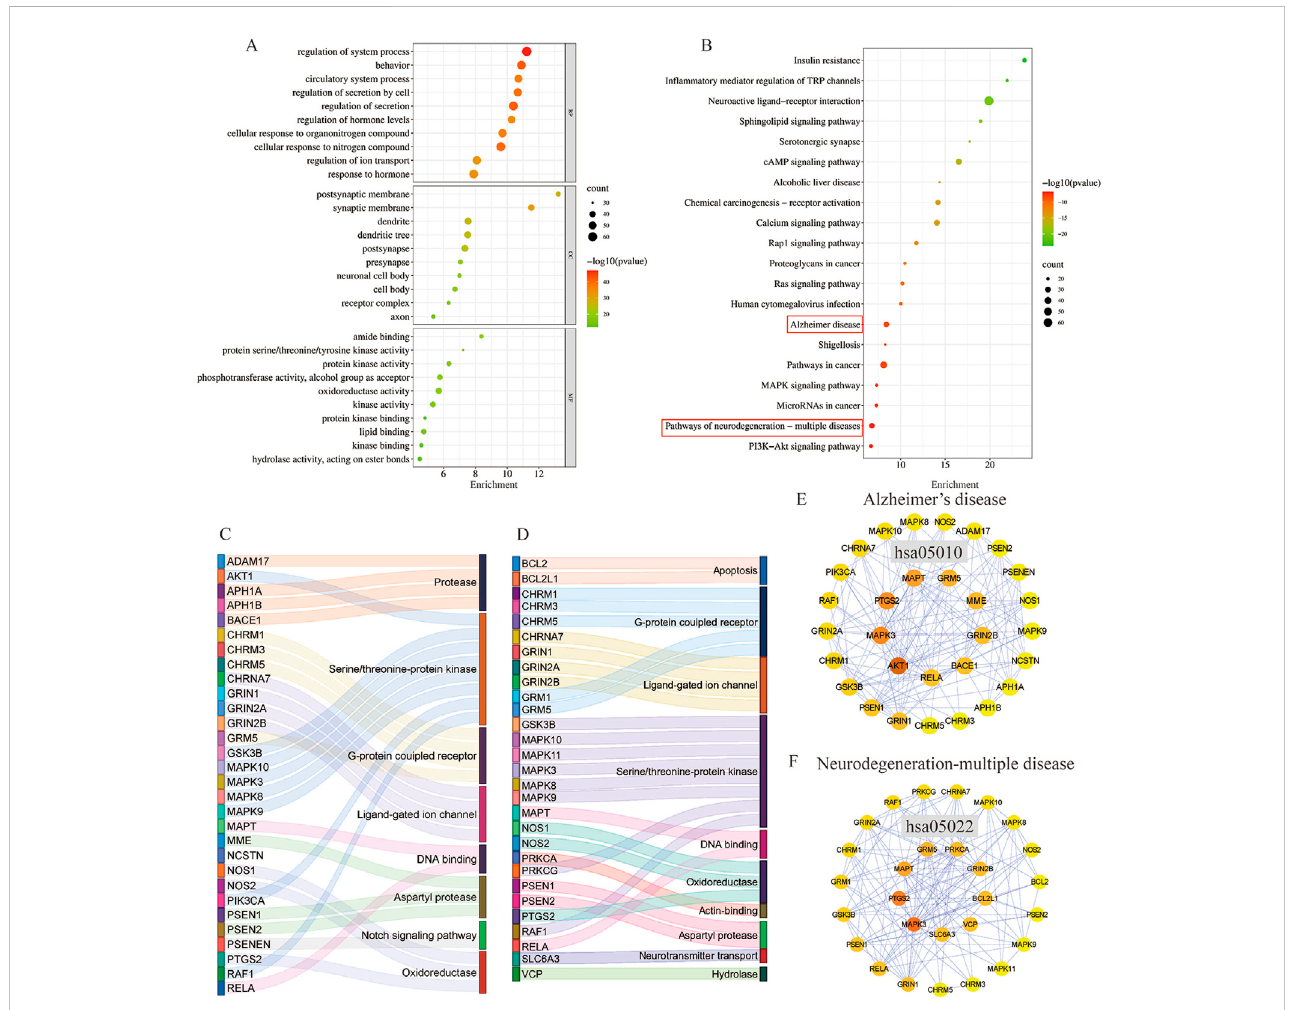
FIGURE 6 GOfunctionenrichmentandKEGGpathwayenrichmentanalysisofADinthetreatmentofMFS. (A) GOfunctionenrichmentanalysisbubblediagram. (B) KEGG pathway enrichment analysis bubble diagram. (C) Sankey diagram of targets involved in the AD signaling pathway. The color of the Sankey diagram indicates the corresponding functional classi fi cation of the gene (classi fi cation according to MF of each target). (D) Sankey diagram of targets involved in the neurodegeneration-multiple disease signaling pathway (classi fi cation according to MF of each target). (E) PPI network of enriched genes in the AD signaling pathway. (F) PPI network of enriched genes in neurodegeneration-multiple disease signaling